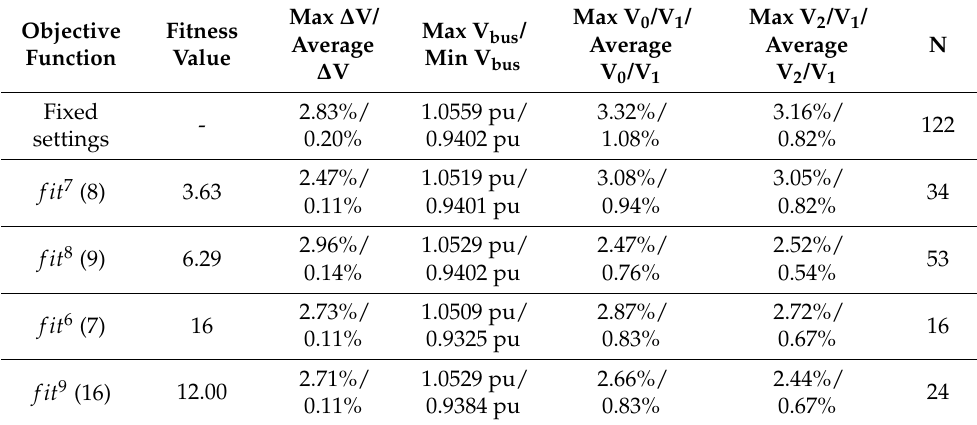
Table 4. The optimization results of each objective function.